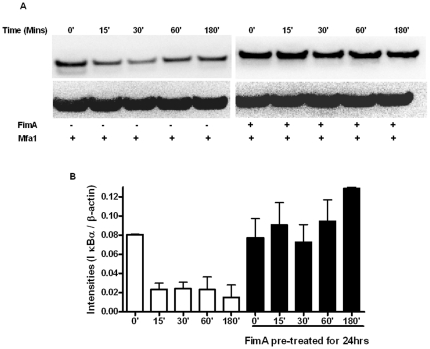
FimA induced tolerance reduces Iκ-Bα degradation.(A) Human PBMCs were pre-treated with 1 µg/ml rFimA for 24 hrs before stimulation with 1 µg/ml of rMfa1 for various timepoints. Immunoblots (25 µg protein per well) were probed for IκBα and re-probed β-actin to ensure equal loading. (B) Mean (s.e.) normalized band intensities.